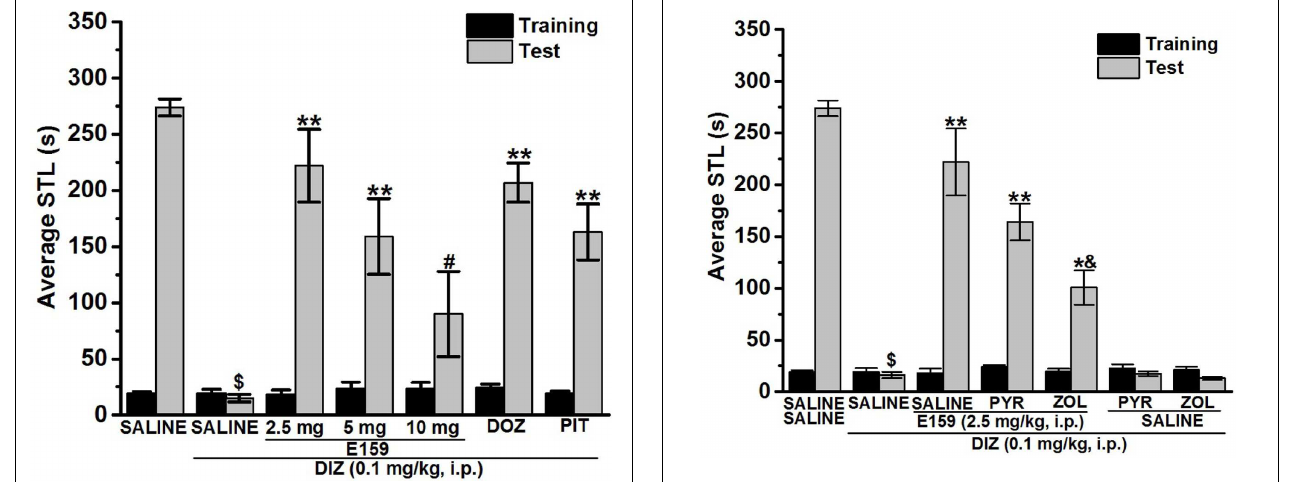
FIGURE 2 | Effects of E159 on DIZ-induced memory deficits in an inhibitory avoidance conditioned response in rats. Gray columns represent the mean STLs measured during the retention test (test latencies) and black columns the mean STLs measured during the training trial before the delivery of the foot-shock (pre-shock latencies). Rats were injected with E159 (2.5, 5, or 10 mg/kg, i.p.), DOZ (1 mg/kg, i.p.), or PIT (10 mg/kg, i.p.) 30–45 min before the test session. ∗∗ P < 0.001 for mean STLs vs. the value of the (saline)-treated group. # P < 0.005 for mean STLs vs. the value of the [E159 (2.5 mg)]-treated group. $ P < 0.001 for mean STLs vs. the value of the (saline)-treated group. Data are expressed as mean ± SEM ( n = 7).